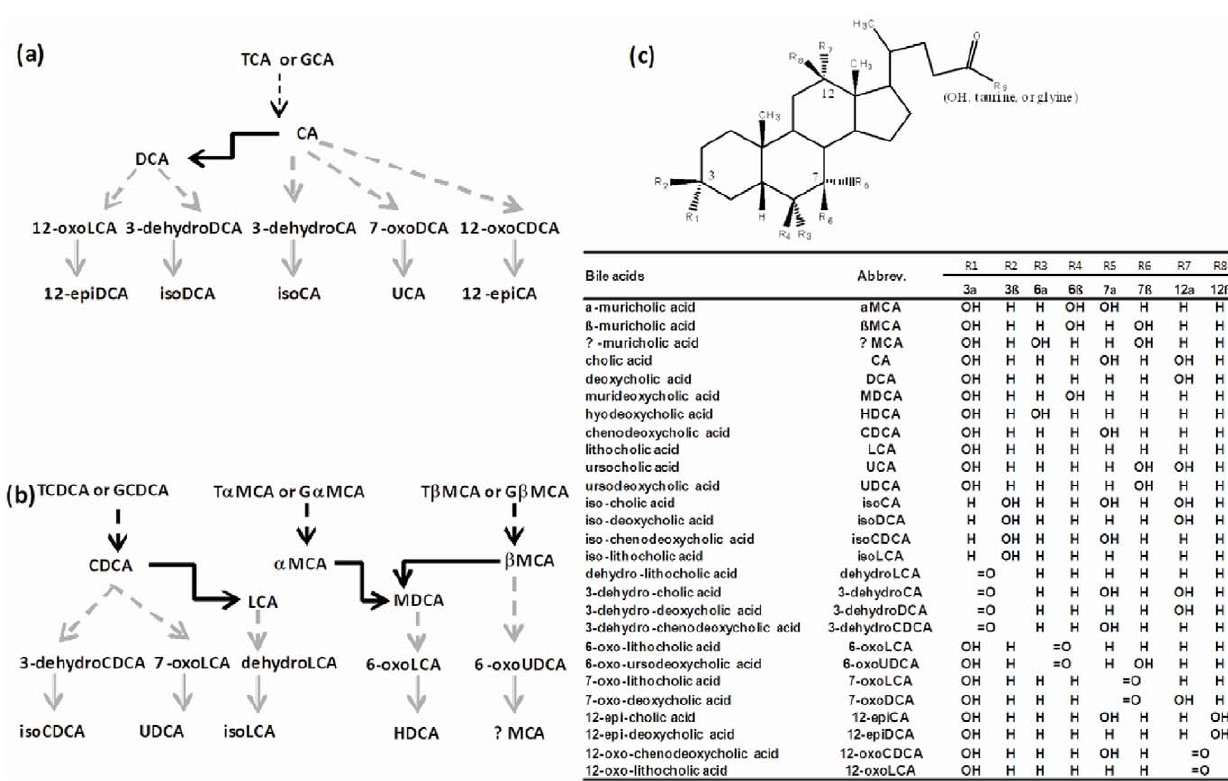
Figure 1. Bacteria-mediated BA metabolism. (a) Deconjugation, dehydroxylation, oxidation, and epimerization of cholic acid (CA) in the intestine of mice. Black dotted arrows represent for deconjugation, black solid arrows represent for 7-dehydroxylation, grey dotted arrows represent for oxidation, grey solid arrows represent for epimerization; (b) Deconjugation, dehydroxylation, oxidation, and epimerization of chenodeoxycholic acid (CDCA) and muricholic acid (MCA) in the intestine of mice. Black dotted arrows represent for deconjugation, black solid arrows represent for 7- dehydroxylation, grey dotted arrows represent for oxidation, grey solid arrows represent for epimerization; (c) Structures and abbreviations of various BAs. TCA and GCA stand for taurocholic acid and glycocholic acid, respectively.